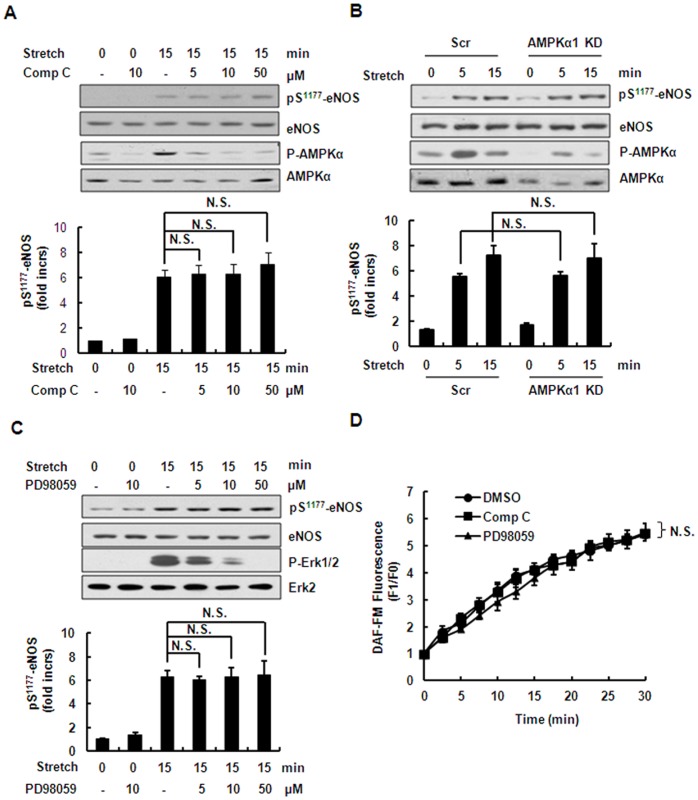
AMPKα and ERK pathways are not involved in stretch-induced phosphorylation of eNOS.
(A) Upper: Western blots of phospho-eNOS (Ser1177) and phospho-AMPKα (Thr172) in HUVECs under continuous stretch, pretreated with Compound C (5–50 µM). Lower: Quantitative analysis of Ser1177 phosphorylation of eNOS. (B) Upper: Western blots of phospho-AMPKα (Thr172) and phospho-eNOS (Ser1177) in HUVECs expressing scrambled (Scr) or AMPKα1-targeting (AMPKα1 KD) shRNAs under continuous stretch. Lower: Quantitative analysis of Ser1177 phosphorylation of eNOS. (C) Upper: Western blots of phospho-Erk1/2 (Thr202/Tyr204) and phospho-eNOS (Ser1177) in HUVECs after stretch, pretreated with PD98059 (5–50 µM). Lower: Quantitative analysis of Ser1177 phosphorylation of eNOS. (D) Quantitative analysis of NO release in HUVECspretreated with 10 µM Compound C or PD980598, under continuous stretch. Results are representative of 3 individual experiments and expressed as mean ± S.D. (n = 4). N.S., not significant.